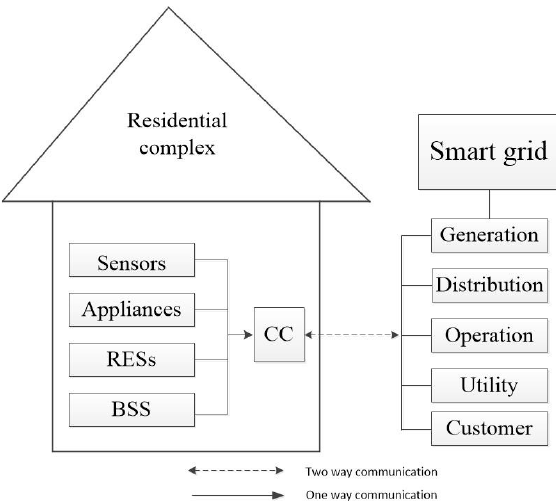
Figure 3. Architecture of the proposed demand side management (DSM).